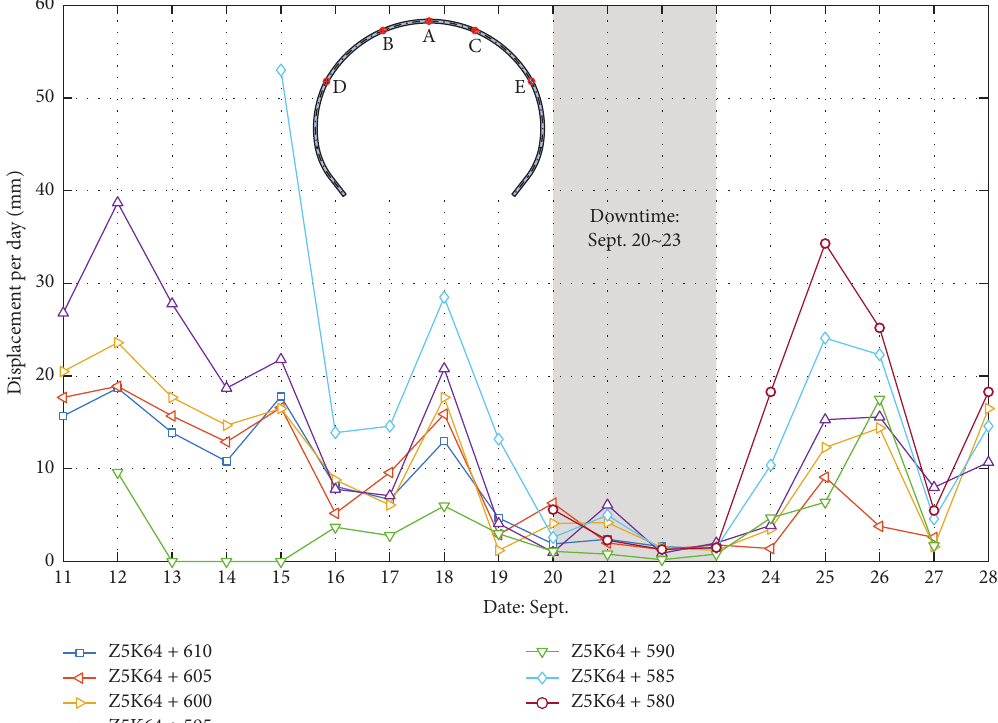
Figure 9: Displacement of point A (tunnel vault) at chainages from Z5K64+610 to Z5K64 +580 during September 11 th to 28 th in